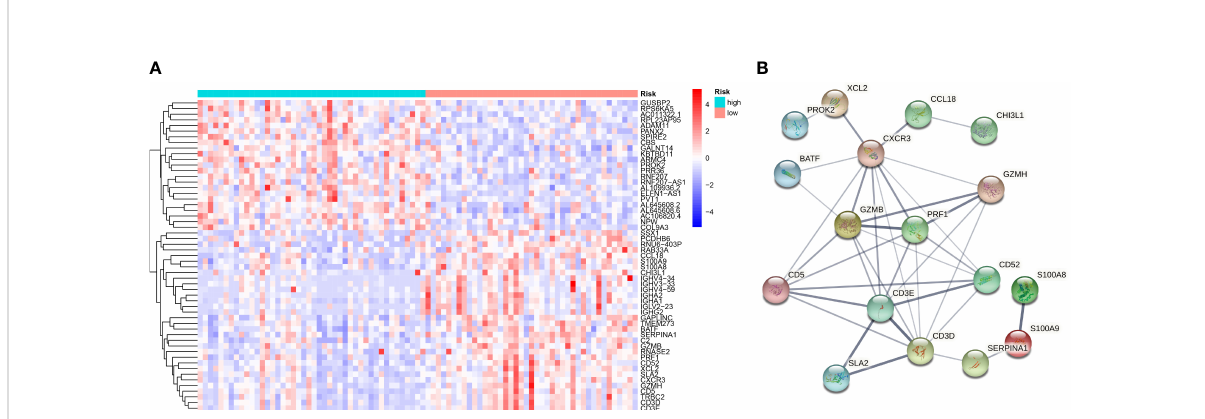
FIGURE 7 Gene Differential Analysis and PPI network for the two groups. (A) A heat map conducted using differently expressed genes in the two groups. (B) PPI network of those genes in the two